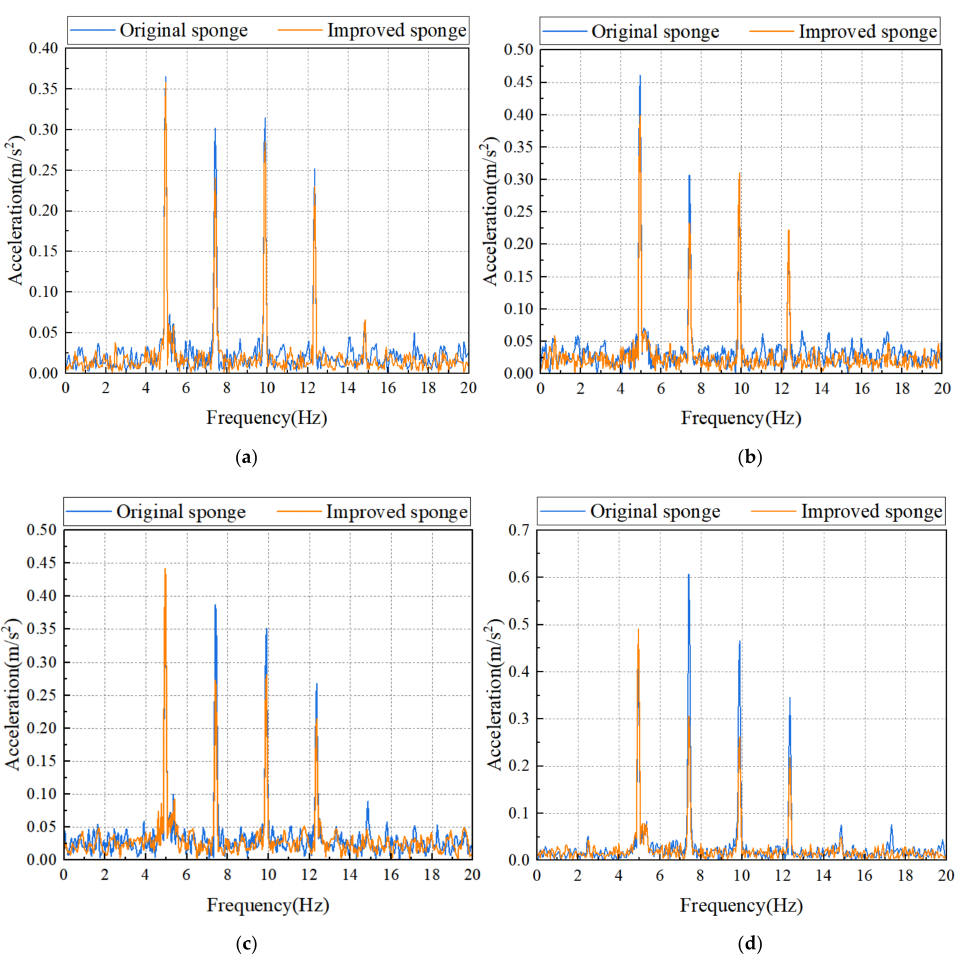
Figure 16. Original and improved seat vibration response with crushing condition: ( a ) Subject 1; ( b ) Subject 2; ( c ) Subject 3; ( d ) Subject